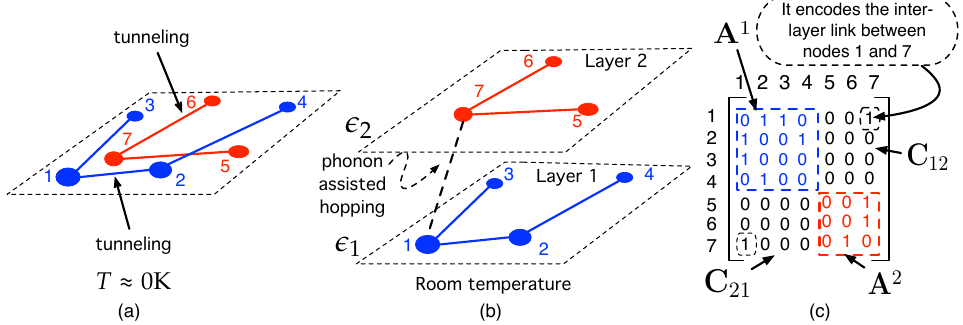
Figure 5. ( a ) A network with sites randomly distributed in space at very low temperature. Blue nodes have energy ε 1 while the red ones, energy ε 2 . ( b ) Example of the emerging multilayer network as T increases. Each layer corresponds to a spatial network whose nodes have the same energy. ( c ) Corresponding adjacency matrix. See the main text for further details. However, as T increases, phonon-assisted transition is allowed, and the network in Figure 5a can now be unfolded into two layers, each corresponding to an energy level, as shown in Figure 5b. At room temperature, node 1, which is spatially very close to node 7, is now linked to node 7 (dotted line) because now there is phonon absorption and p 1,7 > p 1,2 . This is a toy example of a “multilayer network” [102]. Each layer is a network with some properties. In our example, a layer is a network formed by all nodes with the same energy. Figure 5b represents this concept. The first layer represents a network with N 1 = 4 blue nodes with energy ε 1 while the second one contains a network with N 2 = 3 red nodes with energy ε 2 . The complete two-layer network has N 1 + N 2 = 7 nodes. The corresponding binary adjacency matrix of the two-layer network, represented in Figure 5c is made up of the sub-matrices A 1 (the one corresponding to the network in layer 1), A 2 (the adjacency matrix for the network in layer 2), and C 12 and C 21 . These